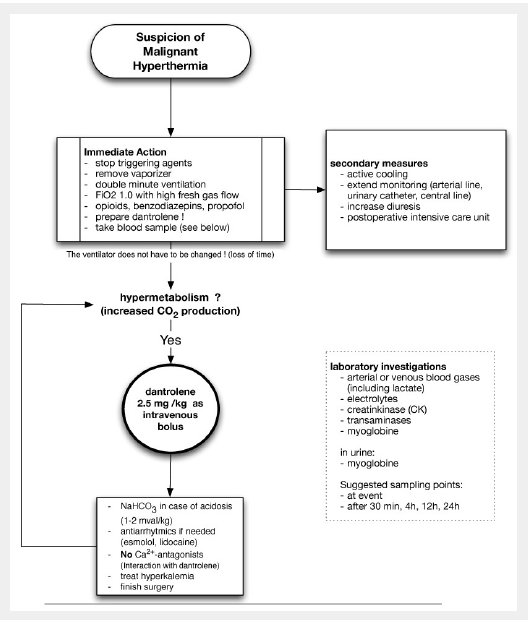
Treatment algorithm for malignant hyperthermia according to the Swiss MH investigation unit.